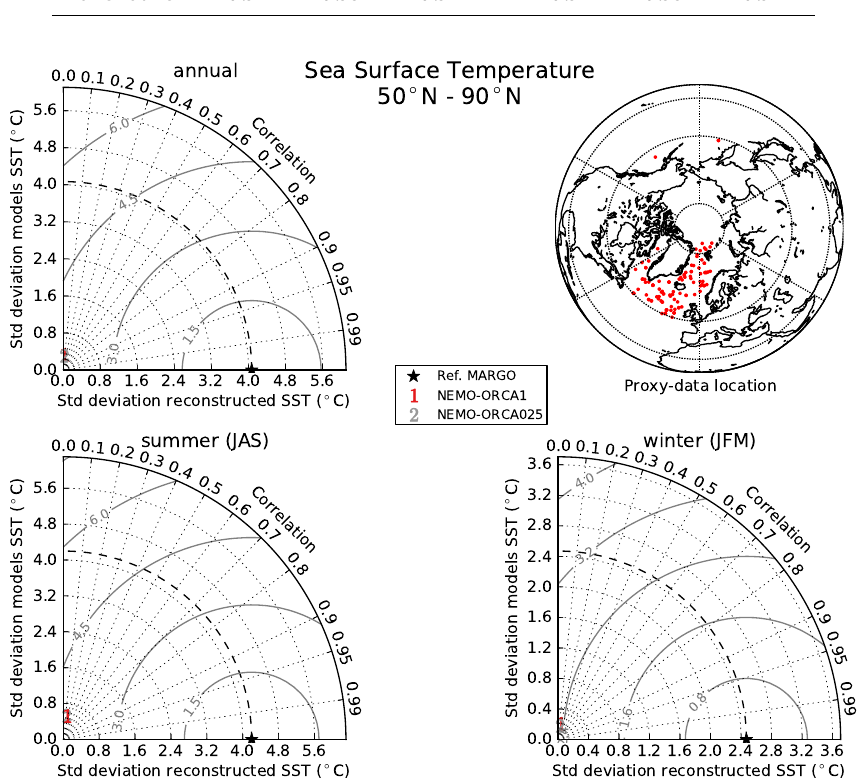
Fig. 9. Taylor diagrams summarizing the correlation coefficient (along the arc), the standard deviations (on the axis) and RMSE (grey solid arcs of circles) for the LGM annual, boreal winter (JFM) and boreal summer (JAS) modelled and reconstructed sea surface temperatures between 50 and 90 ◦ N. The proxy-data locations are shown in the upper right-hand diagram. The NEMO-ORCA1 is symbolized with the number 1, NEMO-ORCA025 with the symbol